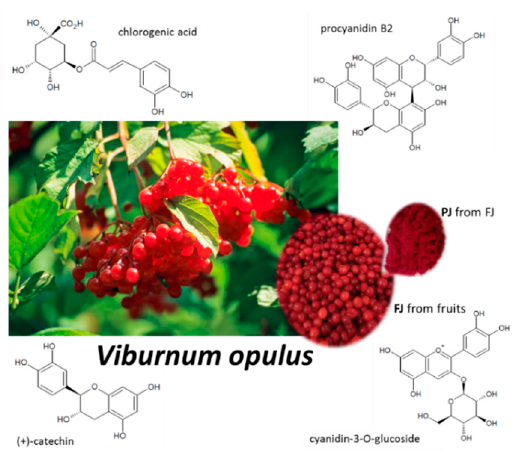
Figure 1. Viburnum opulus fruit as source of fresh juice (FJ) and purified juice (PJ); structures of the main phenolic compounds identified in V. opulus samples.